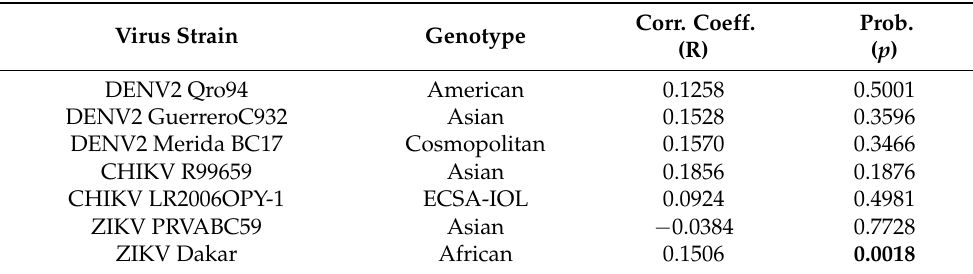
Corr. Coeff. Prob. (R) ( p )